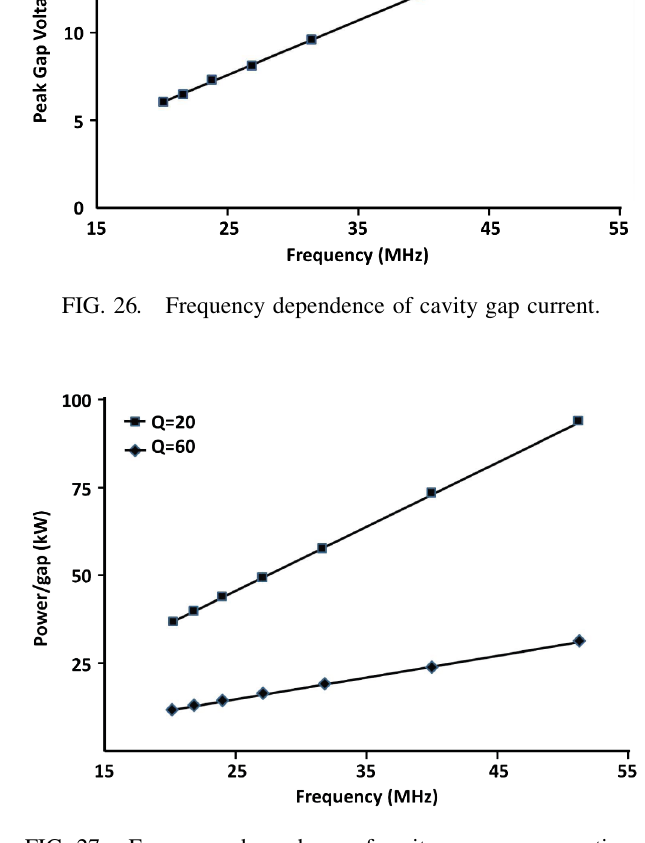
FIG. 27. Frequency dependence of cavity power consumption.